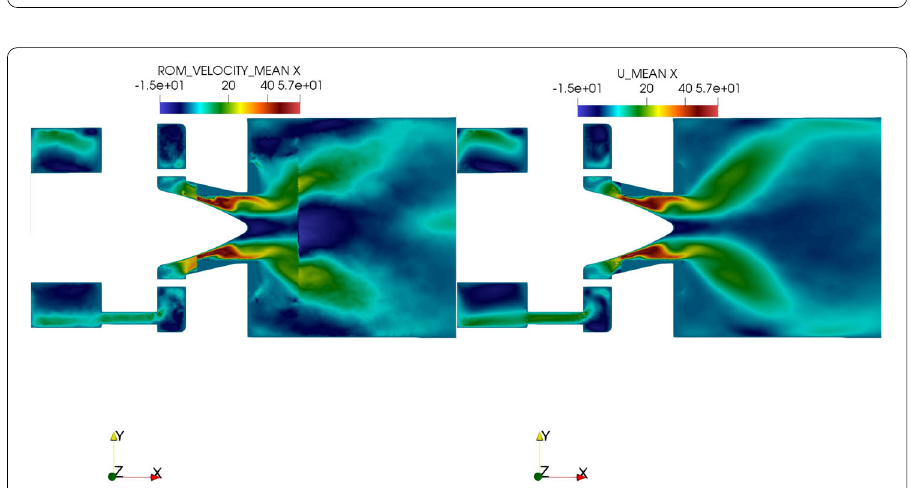
Fig. 46 On the left, the third component of the root mean square flow field by the UGPOD applied to configuration 1. In the middle, the third component of the high fidelity root mean square flow field with configuration 1. On the right, the third component of the high fidelity root mean square flow field with the nominal configuration